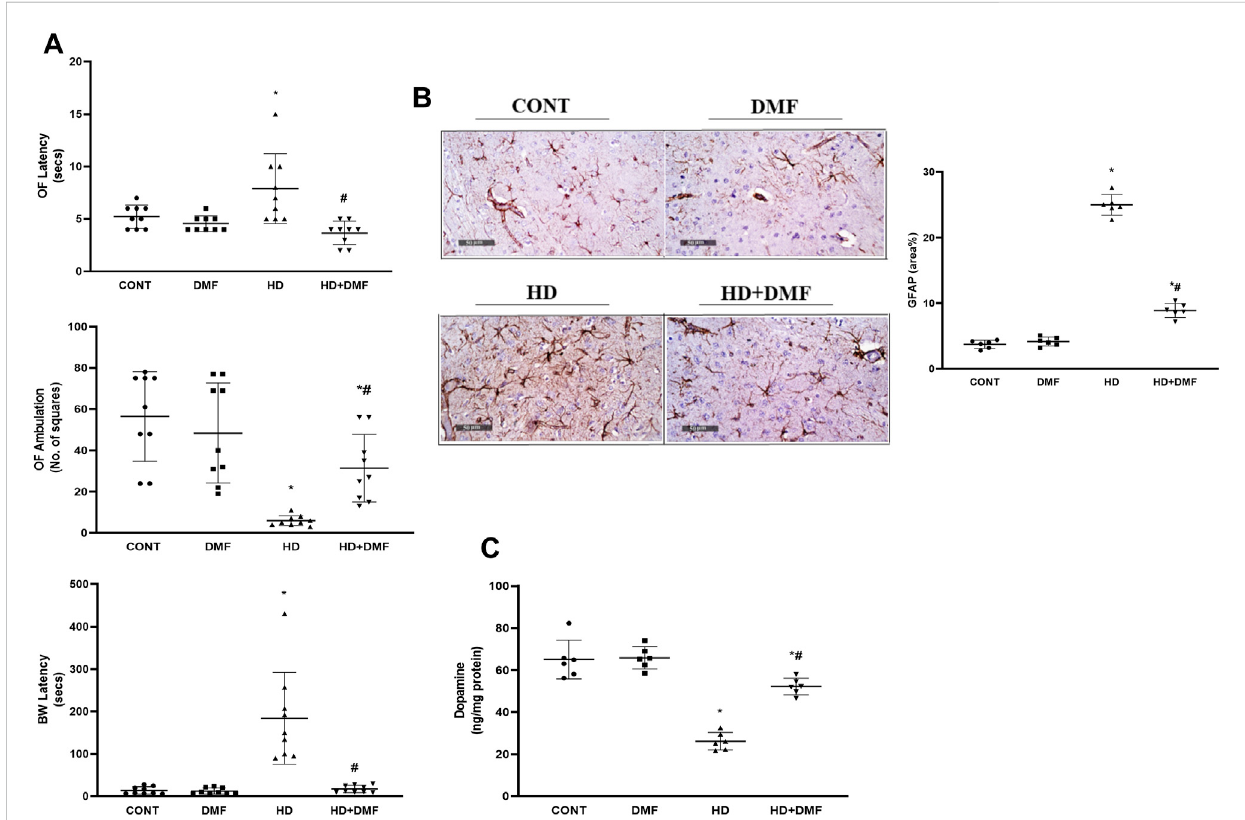
Effect of DMF on (A) latency time/ambulation frequency in the OF and BW latency to platform; (B) GFAP immunoreactivity in striatum and its quantitative analysis; (C) DAcontentinthestriatum ofHDrats. Data (sixnon-overlapping fi elds; n =3rats/group for GFAP; n =6rats/groupfor ELISA;n= 9 rats/group for OF, BW) are represented as mean ± SD and analyzed by one-way ANOVA, followed by Tukey ’ s post hoc test; * vs. CONT and # vs. HD using at p < 0.05. BW, beam walk; CONT, control; DA, dopamine; DMF, dimethyl fumarate; GFAP, glial fi brillary acidic protein; HD, Huntington ’ s disease; OF, open fi